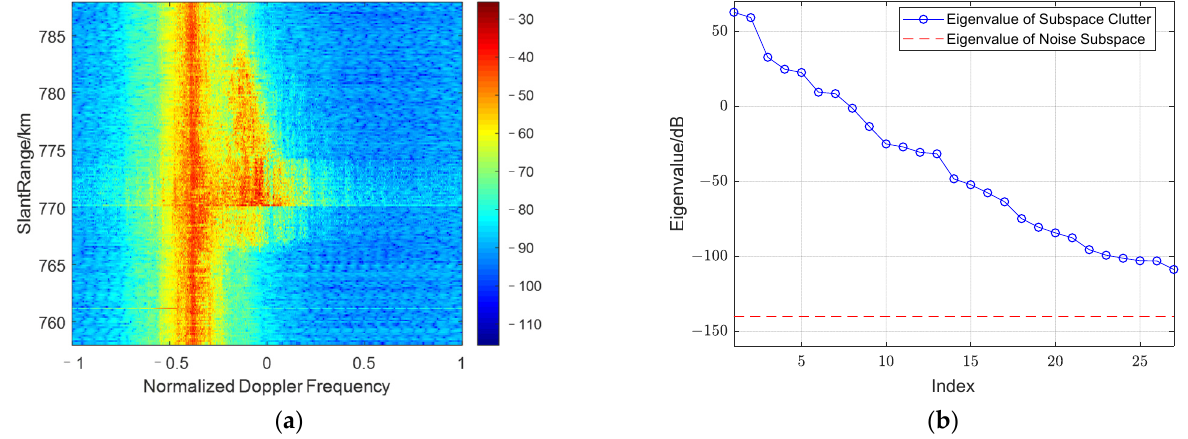
Figure 17. ( a ) The range-Doppler output power spectrum after using traditional elevation 3D-JDL- STAP; ( b ) The eigenvalue spectrum of reduced dimensional clutter covariance matrix. It can be found through Figure 17b that since the covariance matrix of the subspace clutter is nonsingular, which represents the lack of additional DOFs for the adaptive system to accurately suppress the received clutter, the clutter in the near-end range ambiguous positions is difficult to be suppressed and the overall clutter suppression performance is reduced significantly. Figure 18 shows the output power spectrum of the Doppler channels where different moving targets are located, respectively, and it can be seen that the faint moving targets in the near-end range ambiguous positions and near the main lobe region are difficult to be detected using the traditional 3D joint adaptive processing method.